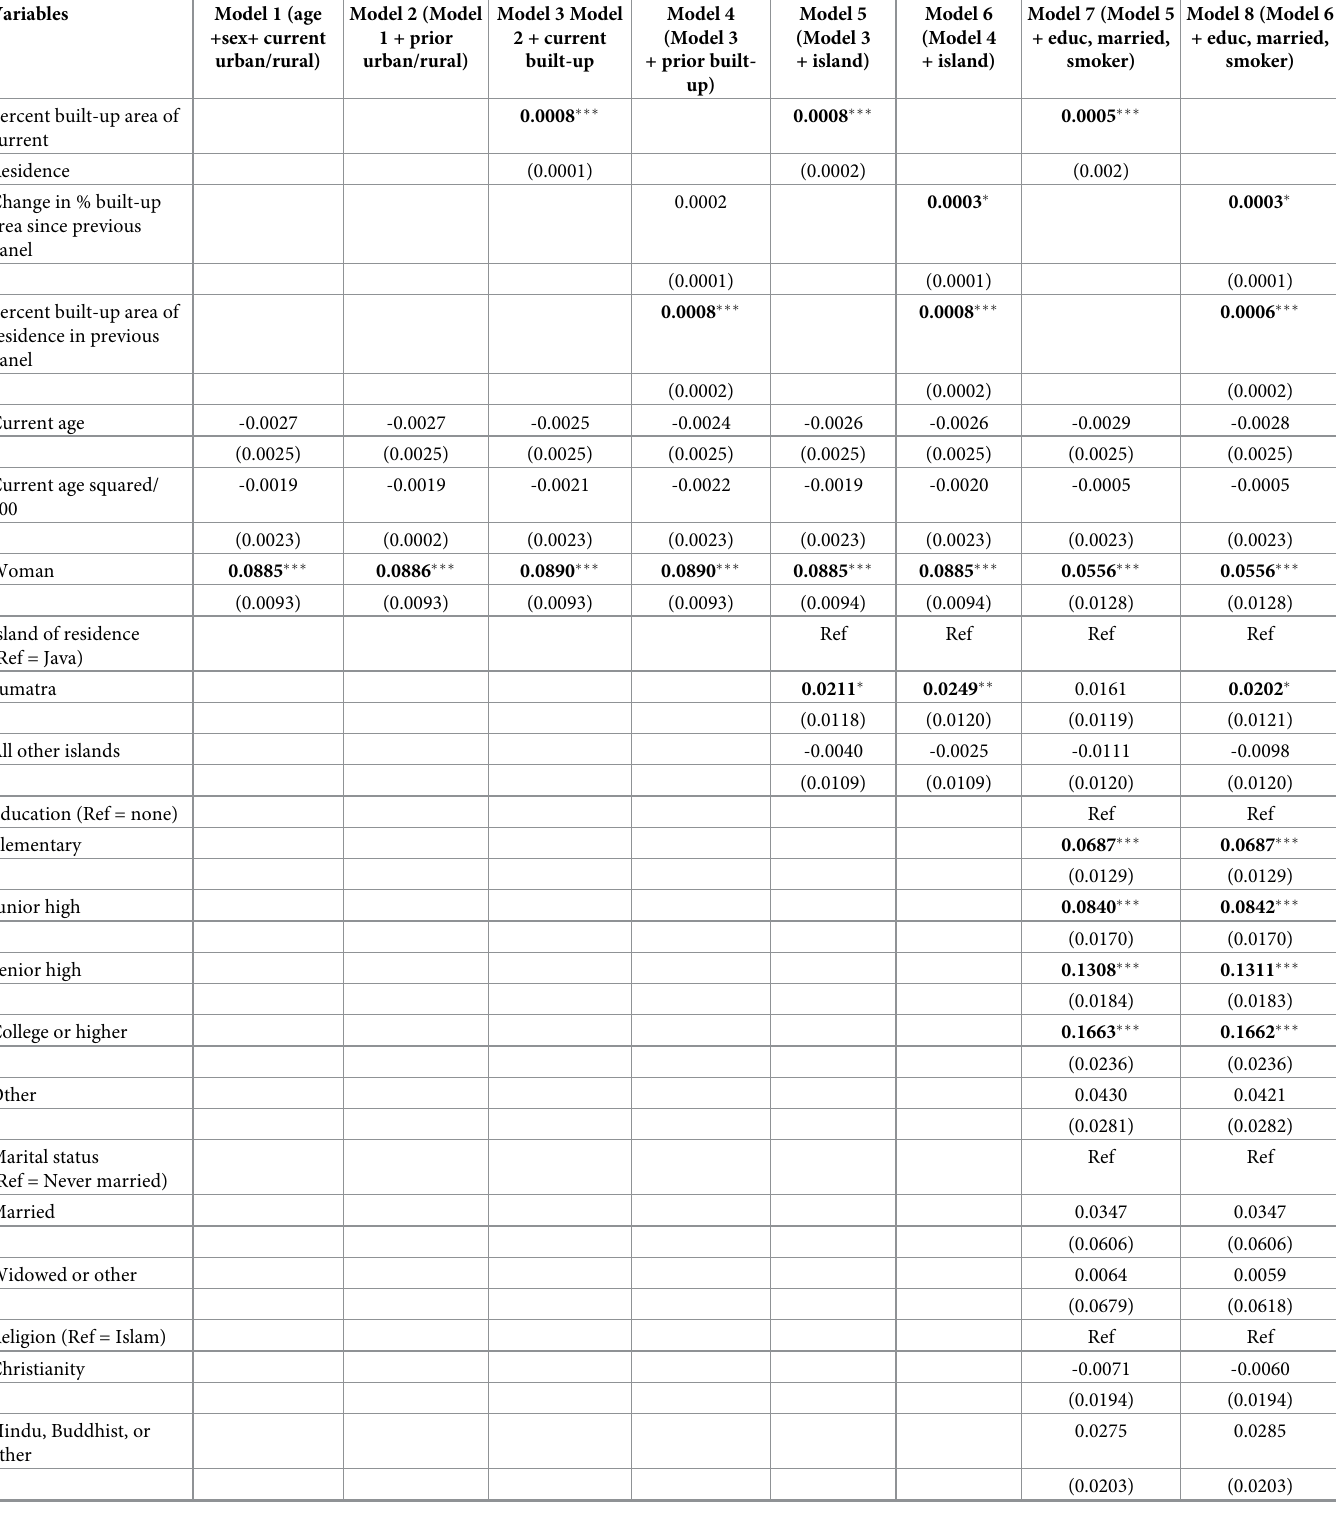
Table 6. Value-added linear regression model predicting overweight/obese, pooled